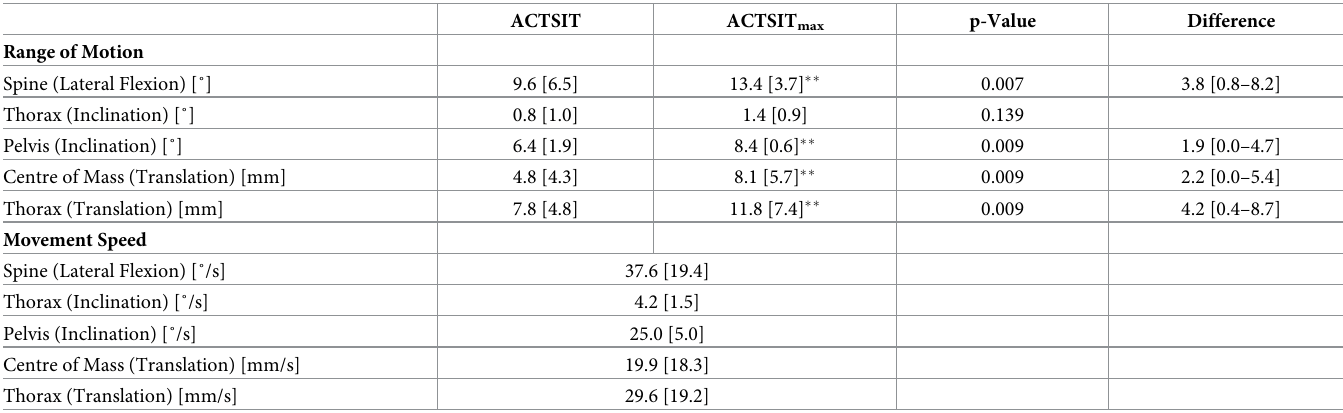
Table 4. Range of motion and movement